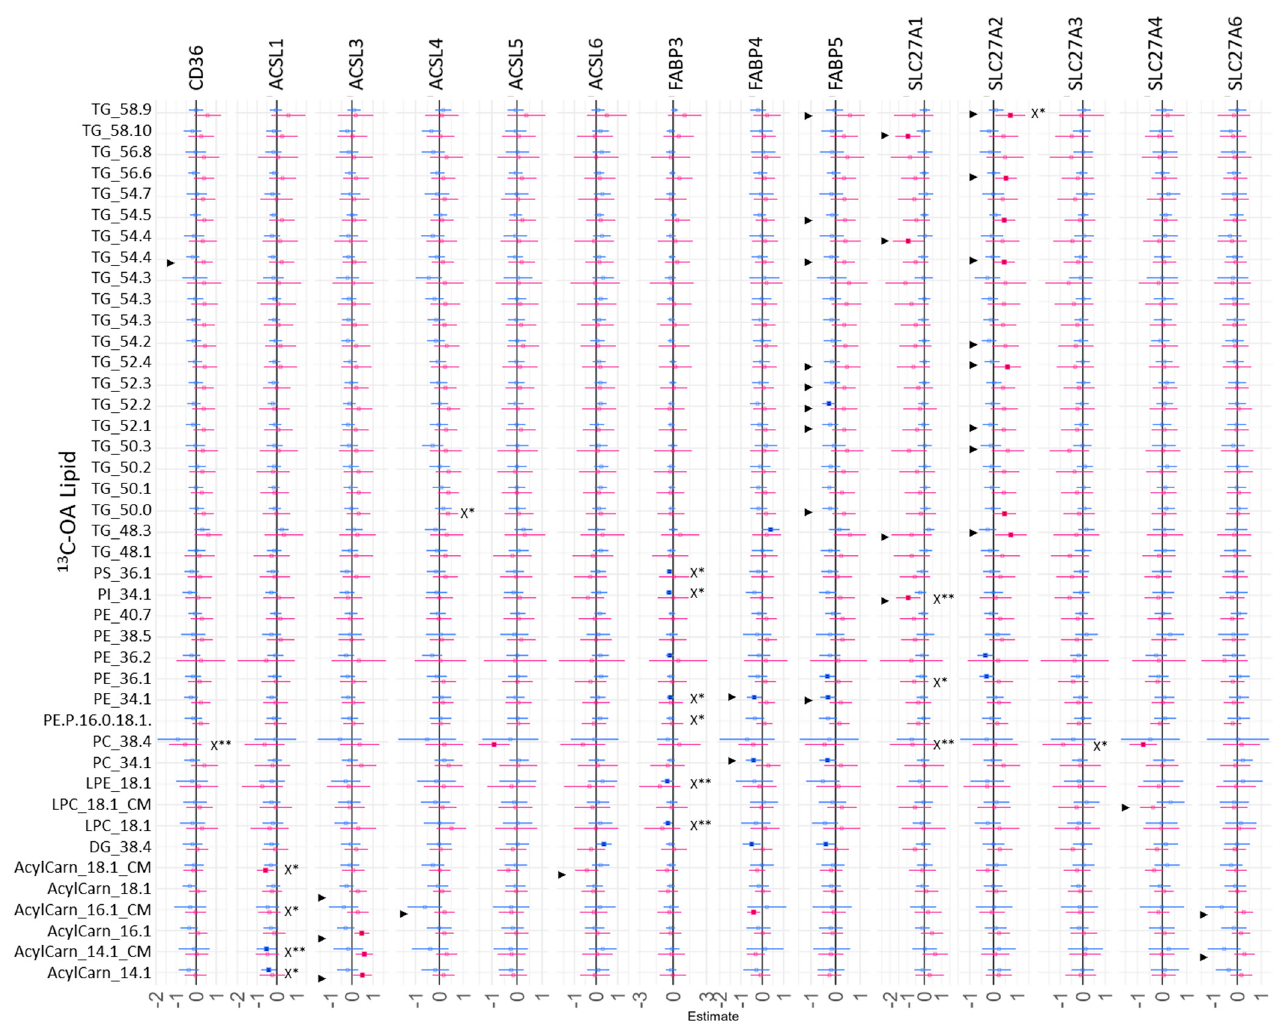
Figure 7. Sex-stratified associations between the amount of 13 C-OA lipids (outcome) with relative mRNA abundance after 48 h of culture. Lipid amount was log2 transformed, mRNA abundance was log-2 transformed and z-scored. Linear regression with males and females combined (not shown) with significance p < 0.05 is indicated by X*, whilst significance p < 0.01 is indicated by X**. Interaction between sex*relative mRNA abundance on lipid amount were then investigated with significant interactions p < 0.05 denoted by “ ► ”. Linear regression was then run separately for males and females. Forest plots show association coefficient and 95% confidence intervals for males (blue) and females (red) with significance ( p < 0.05 shown by dark-colored filled squares. The Benjamini–Hochberg method was used to correct for multiple testing.